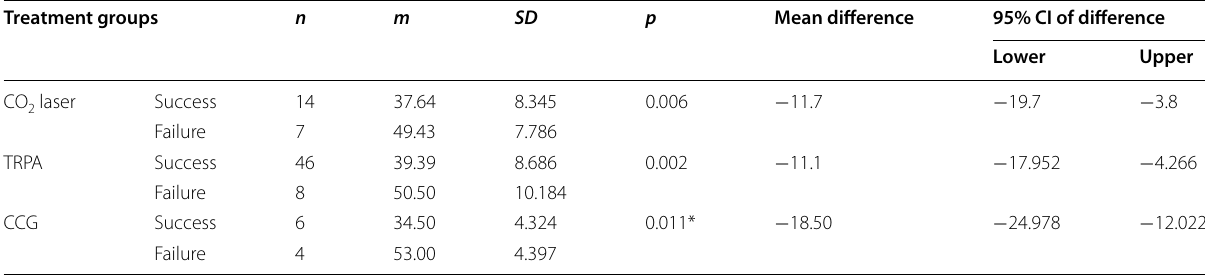
TRPA tracheal resection with primary anastomosis, CCG costal cartilage graft * p -value obtained from the Mann-Whitney U -test